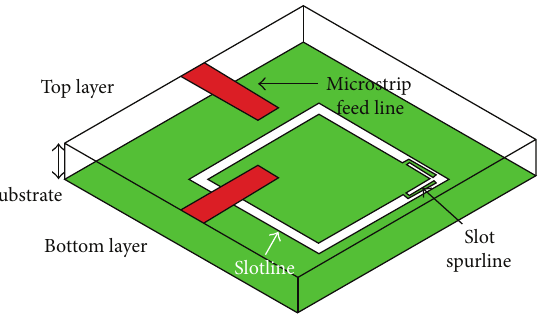
Figure 2: Three-dimensional view of a slotline square resonator with a pair of slot